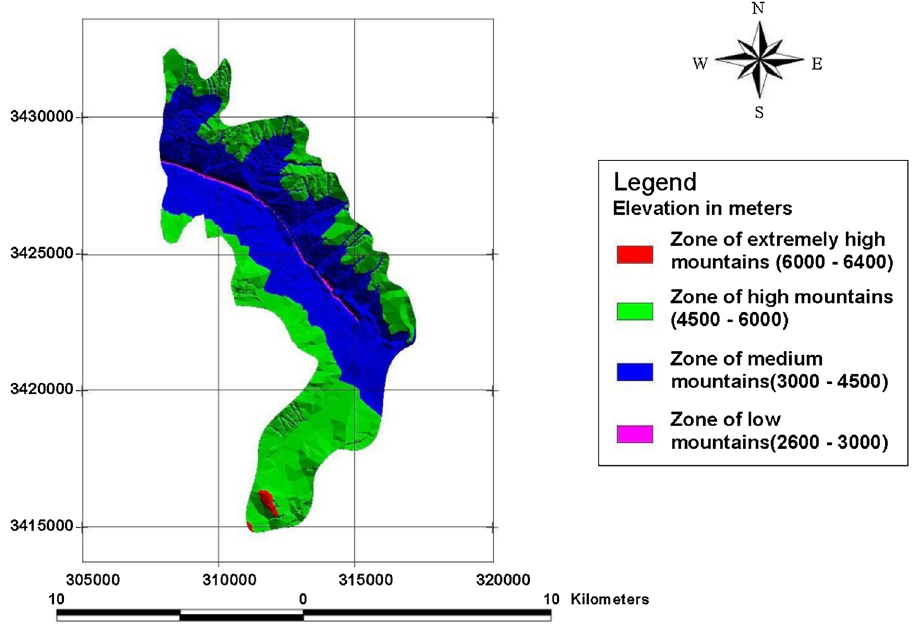
Fig. 10 Altitudinal zones of the Gangotri glacier area